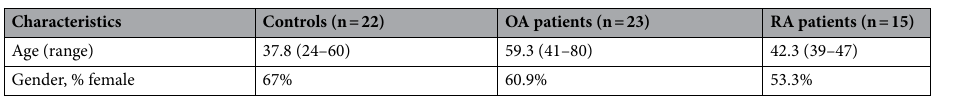
Table 2. Demographic characteristics for the different cohorts used for the biological validation of the PAR2 immunoassay. Data are shown as mean (range).